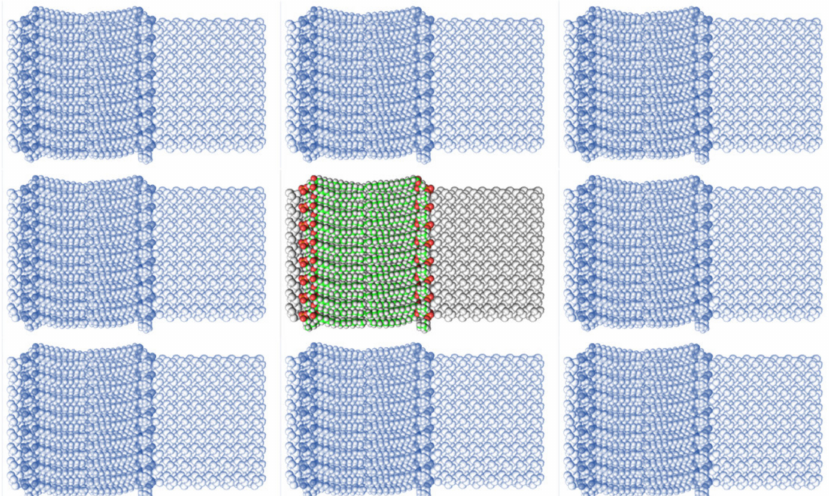
Figure 3. A system (colored) consisting of a phospholipid bilayer, water molecules, and a peptide inside water (not visible), as well as its images (monochrome) under periodic boundary